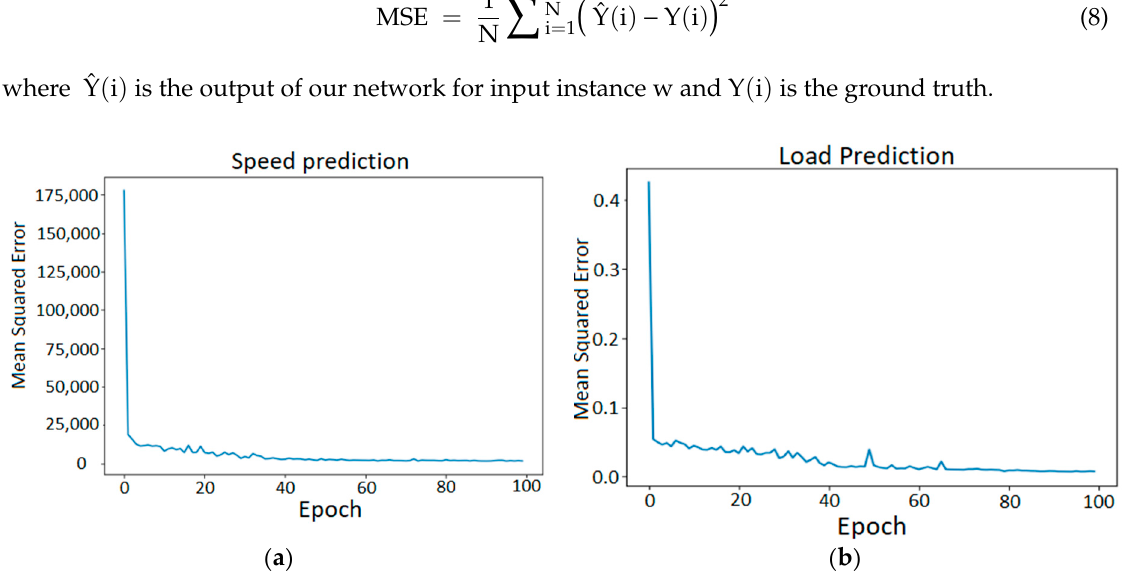
Figure 9. Speed ( a ) and Load prediction; ( b ) Mean Squared Error as a function of Training Epochs.